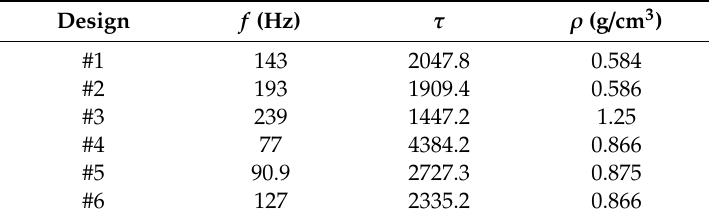
Table 3. Resonant Frequency Analysis: 3D Printed Nylon Cantilevers.